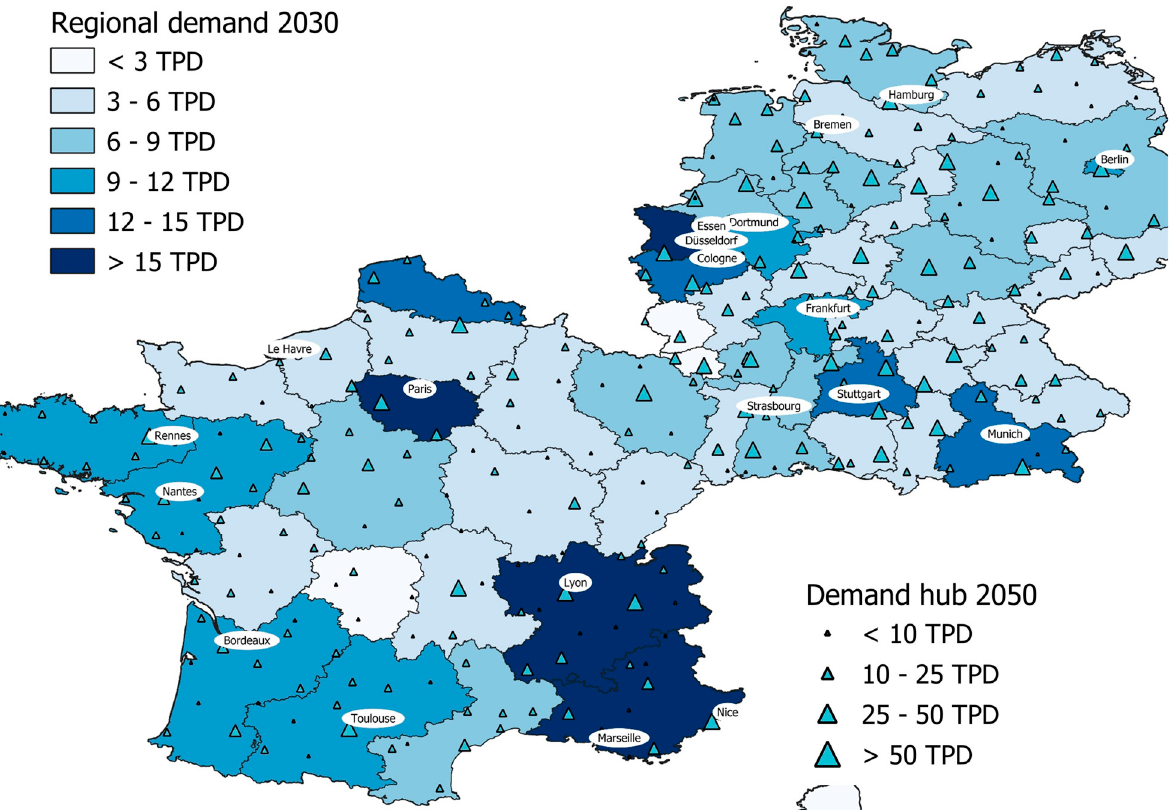
Figure 2. Regional demand for 2030 and demand hub capacities for 2050.